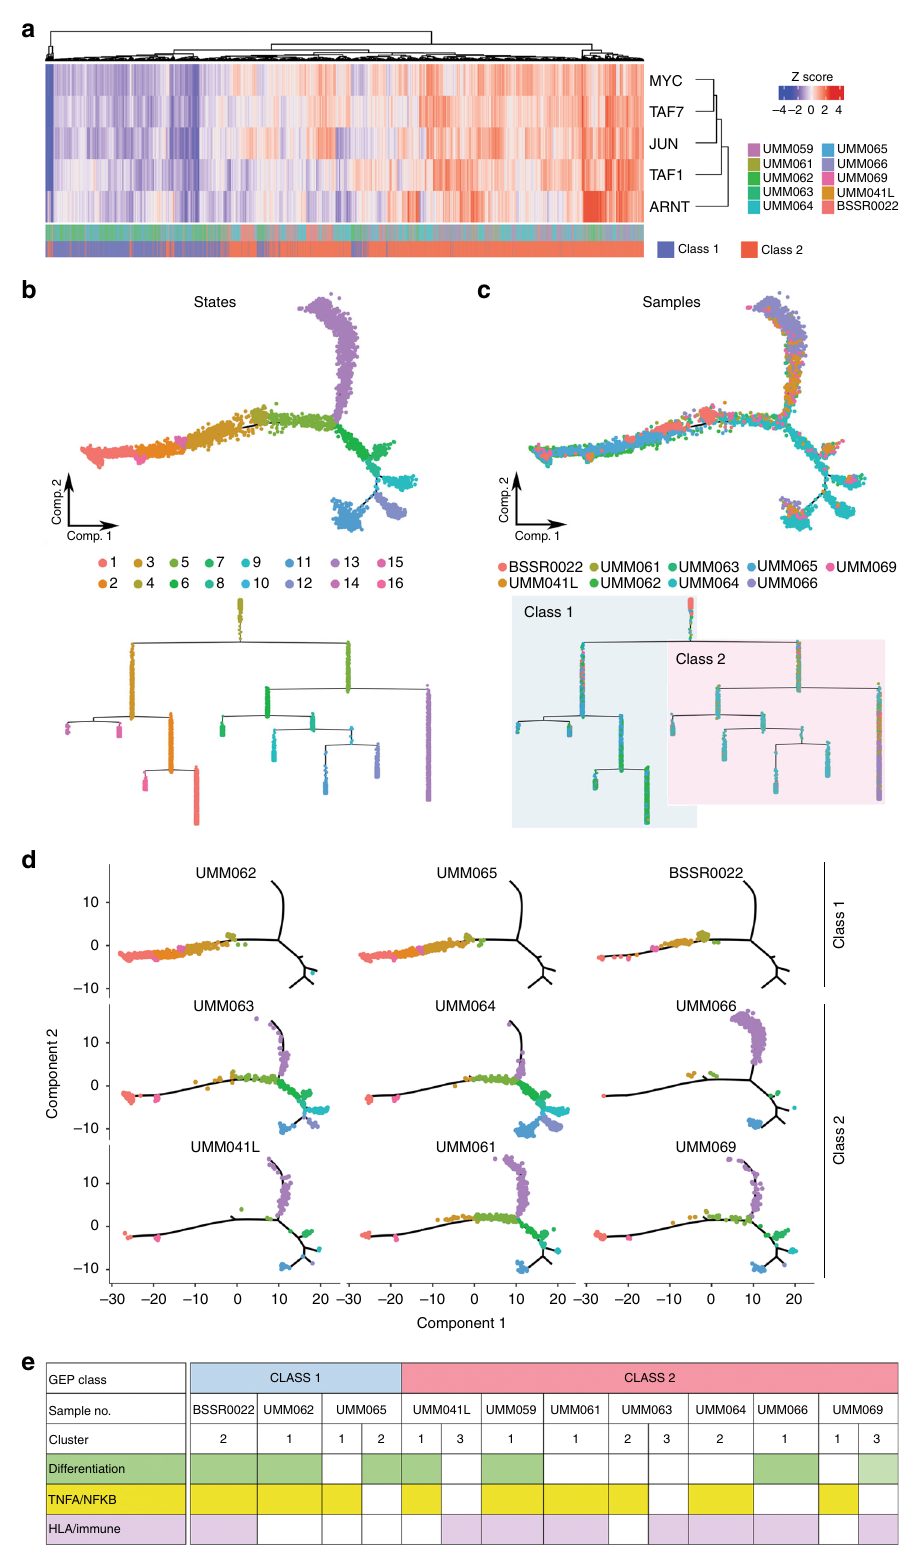
Fig. 3 Trajectory analysis of uveal melanoma cells. a Enriched transcription factor motifs determined using SCENIC analysis of 8,598 tumor cells and displayed as a heatmap of z-scored enrichment values. b Monocle 2 trajectory analysis of 7,947 uveal melanoma cells obtained by 5 ′ gene expression chemistry annotated by calculated states. c Trajectory analysis annotated by sample and overlaid with color by GEP class. d Combined Monocle 2 trajectory analysis displayed by each sample and annotated by calculated state. e Chart depicting pathways found to be signi fi cant by MSigDB analysis of each sample cluster determined by BEAM analysis followed by hierarchical